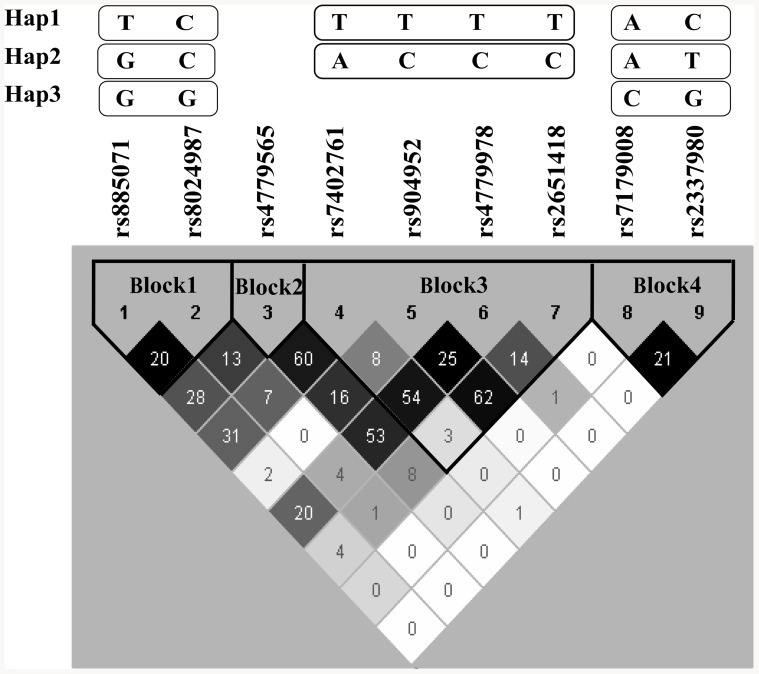

CHRNA7 linkage disequilibrium (LD) plot.The plot was generated by applying the Haploview program to genotype data from this study. The level of pairwise D', which indicates the degree of LD between two SNPs, is shown in the LD structure in gray scale. The level of pairwise r2, which indicates the degree of correlation between two SNPs, is indicated by the number in the cell. Different numbers of common (frequency ≥5%) haplotypes were identified in each haplotype block. A modified Gabriel et al. algorithm was used to define the haplotype block [32], [33].